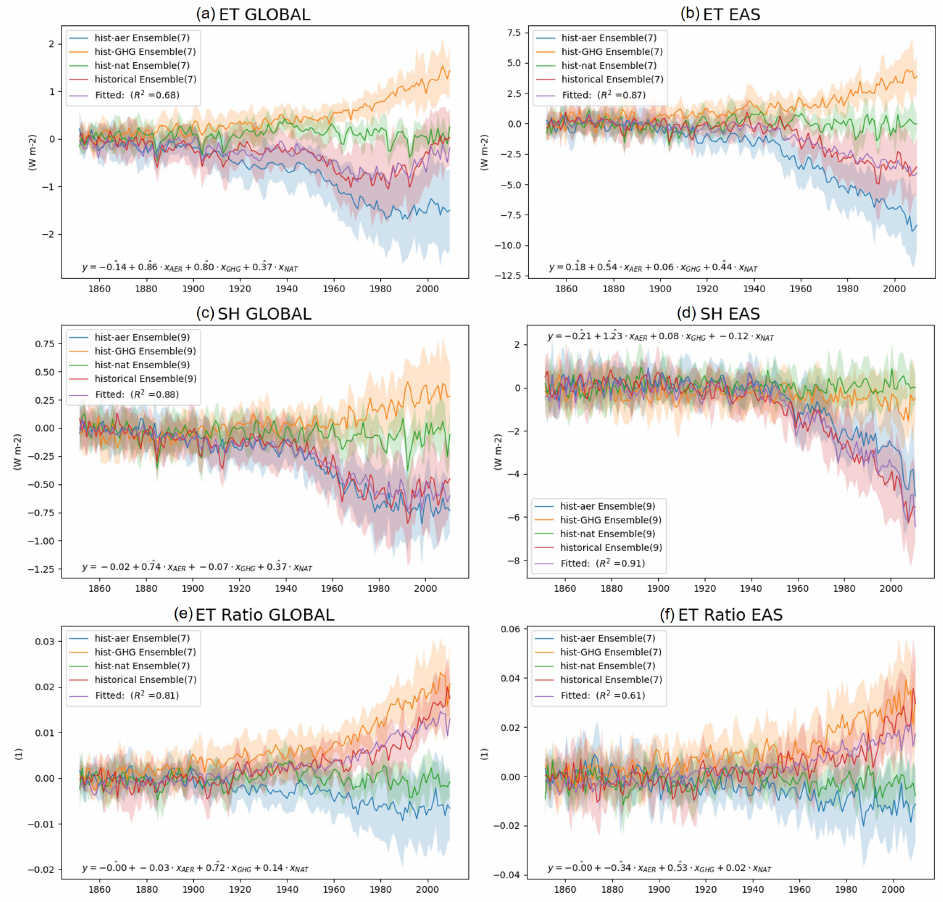
Figure 5. Results of latent heat ( ∼ evapotranspiration, ET) and sensible heat (SH) flux analyses and their ratio (ET Ratio): ( a ) time series plot of global ET; ( b ) plot of ET in East Asia; ( c ) plot of global SH; ( d ) plot of SH in East Asia; ( e ) plot of global ET Ratio; ( f ) plot of ET ratio in East Asia. The titles above the plots and the legends within the plots are followed by the number of ensemble models in parentheses, and the estimated parameters with hats provide statistical significances ( p -value ≤